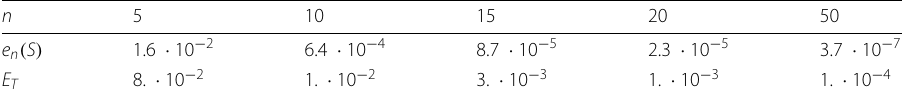
Table 9 Errors e n and E T with the S spline for (27)